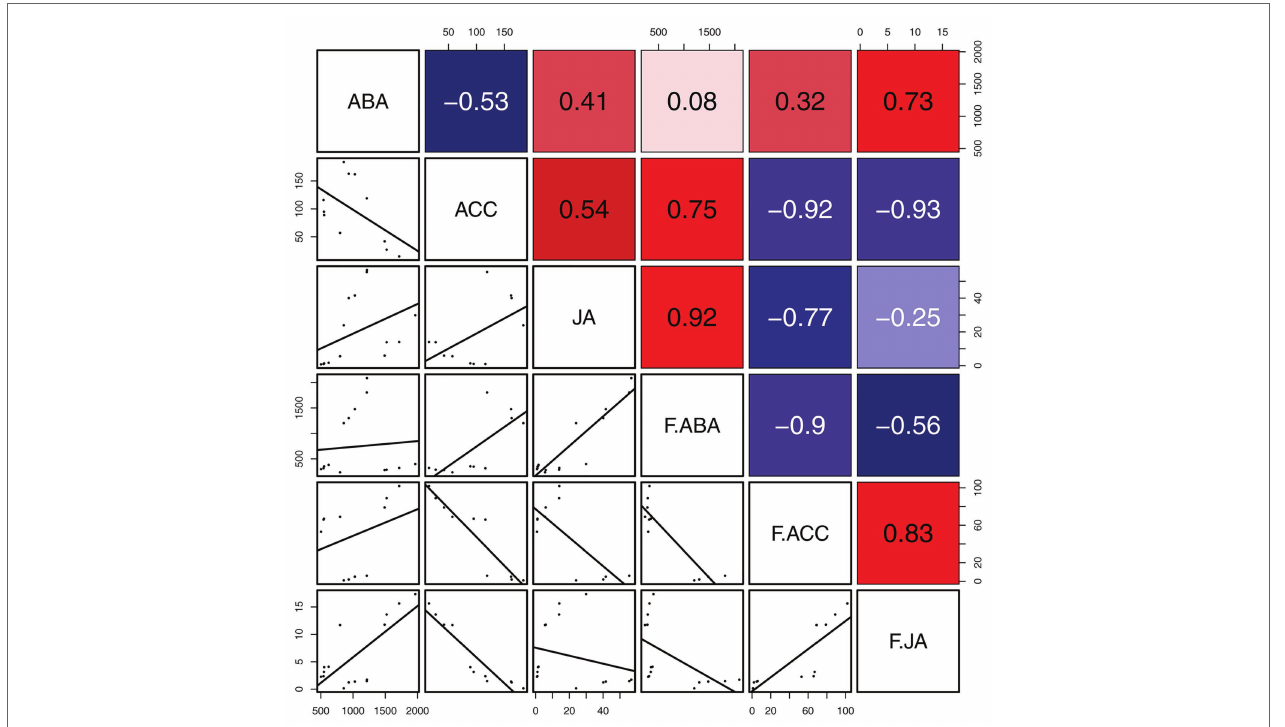
FIGURE 7 | Correlation of defense related phytohormones between gall tissues and cones. Mean differences were compared using t -tests ( p < 0.05). Red and blue boxes represent positive and negative correlations,